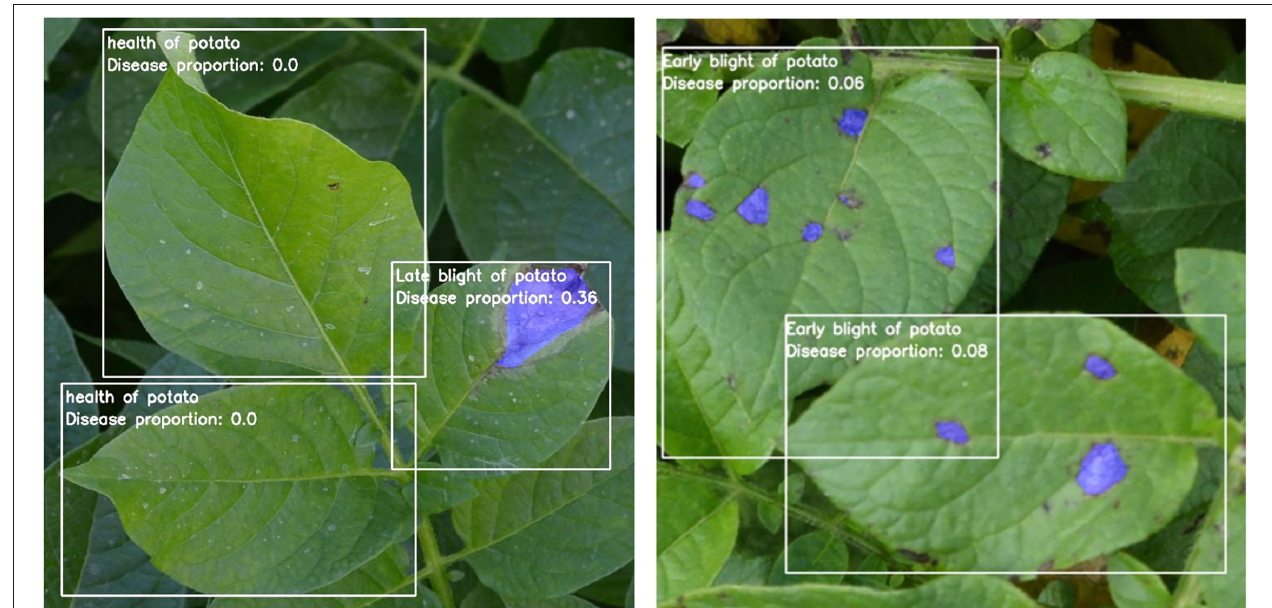
FIGURE 9 | The results of detection and recognition of potato leaves under the three-stage